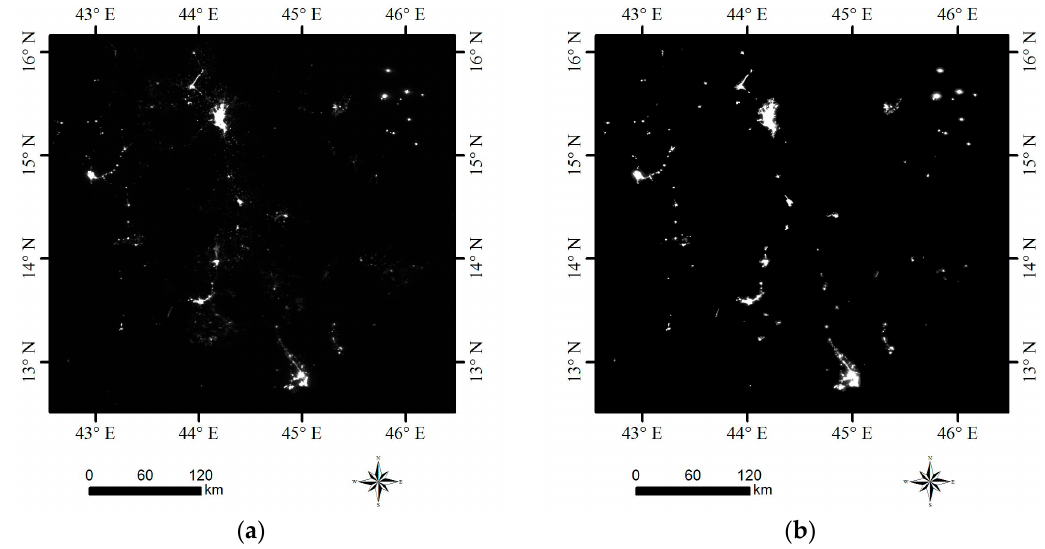
Figure 7. Nighttime light images before and after correction: ( a ) original image and ( b ) corrected image.